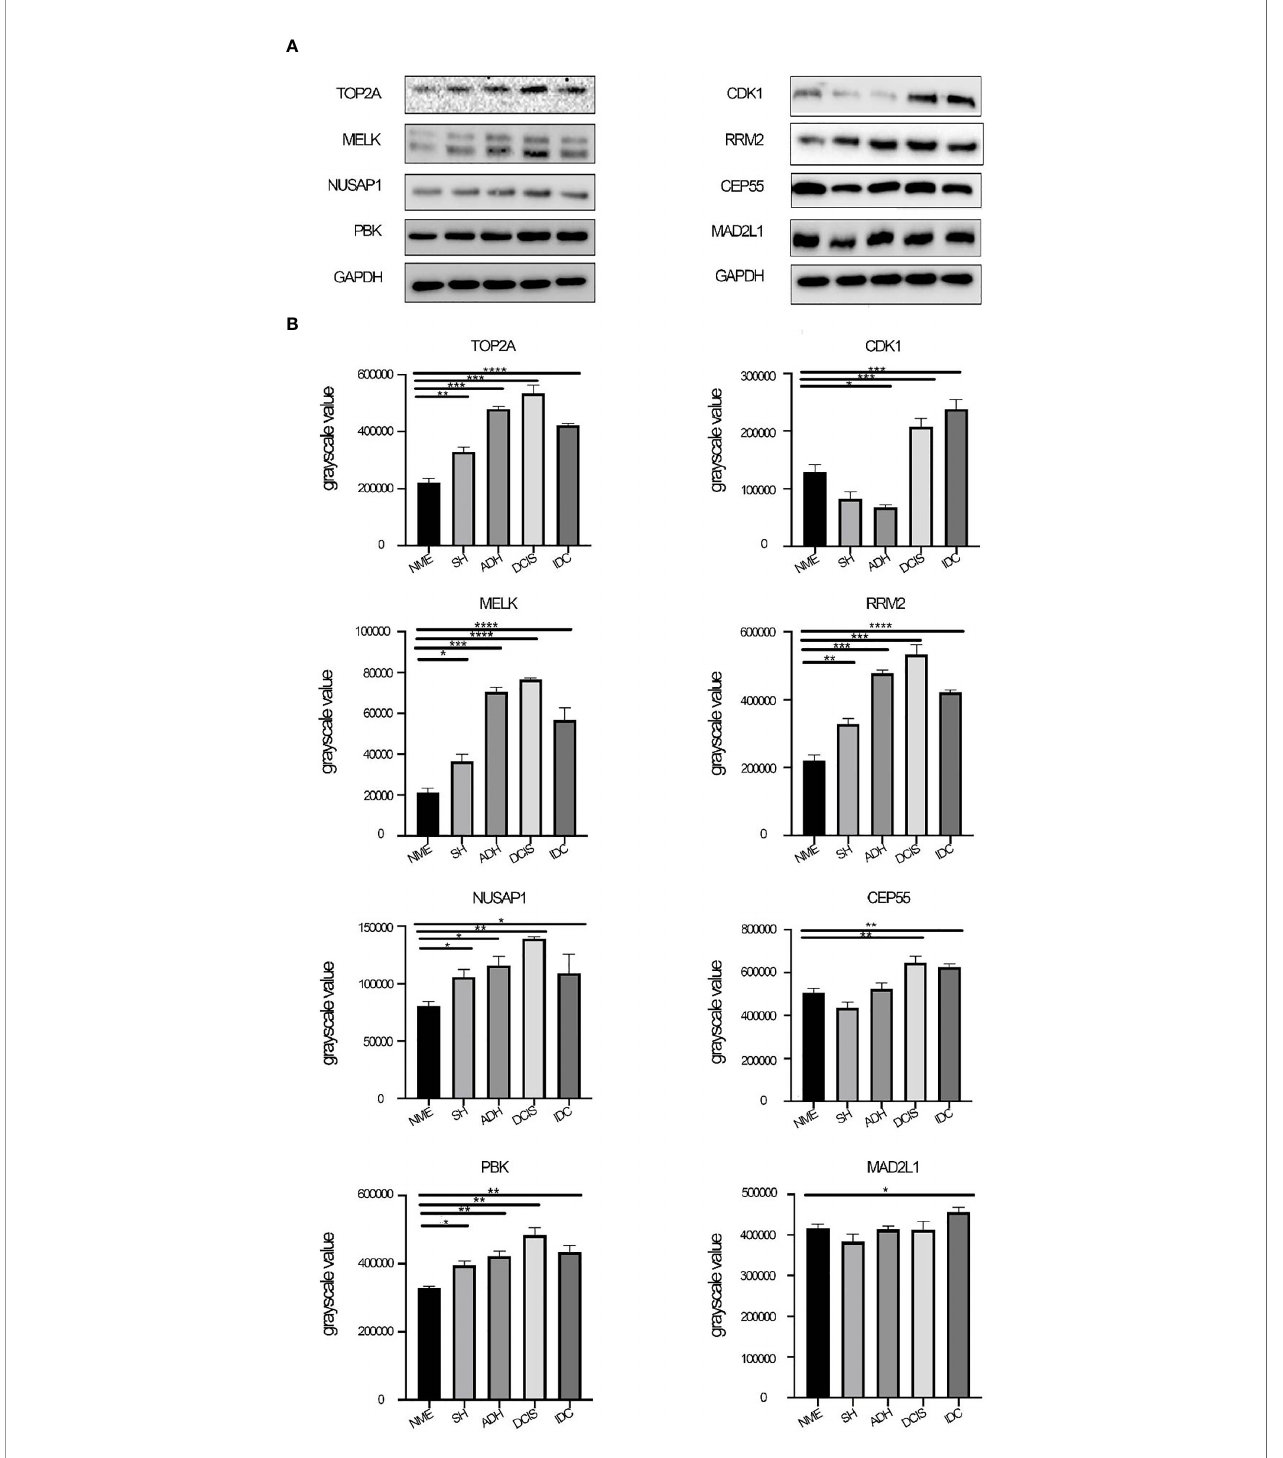
FIGURE 6 | Protein expression levels of hub genes. (A) Protein expression levels of CDK1, MELK, CEP55, TOP2A, NUSAP1, PBK, RRM2, and MAD2L1 were determined by western blotting. (B) Western blot analysis of CDK1, MELK, CEP55, TOP2A, NUSAP1, PBK, RRM2, and MAD2L1 in tissue from different stages of breast disease, and quanti fi cation of the intensity relative to GAPDH. One-way ANOVA was performed to acquire statistical signi fi cance (*p < 0.05, **p < 0.01, ***p < 0.001, ****p < 0.0001). NME, normal mammary epithelium; SH, simple ductal hyperplasia; ADH, atypical ductal hyperplasia; DCIS, ductal carcinoma in situ; IDC, invasive ductal